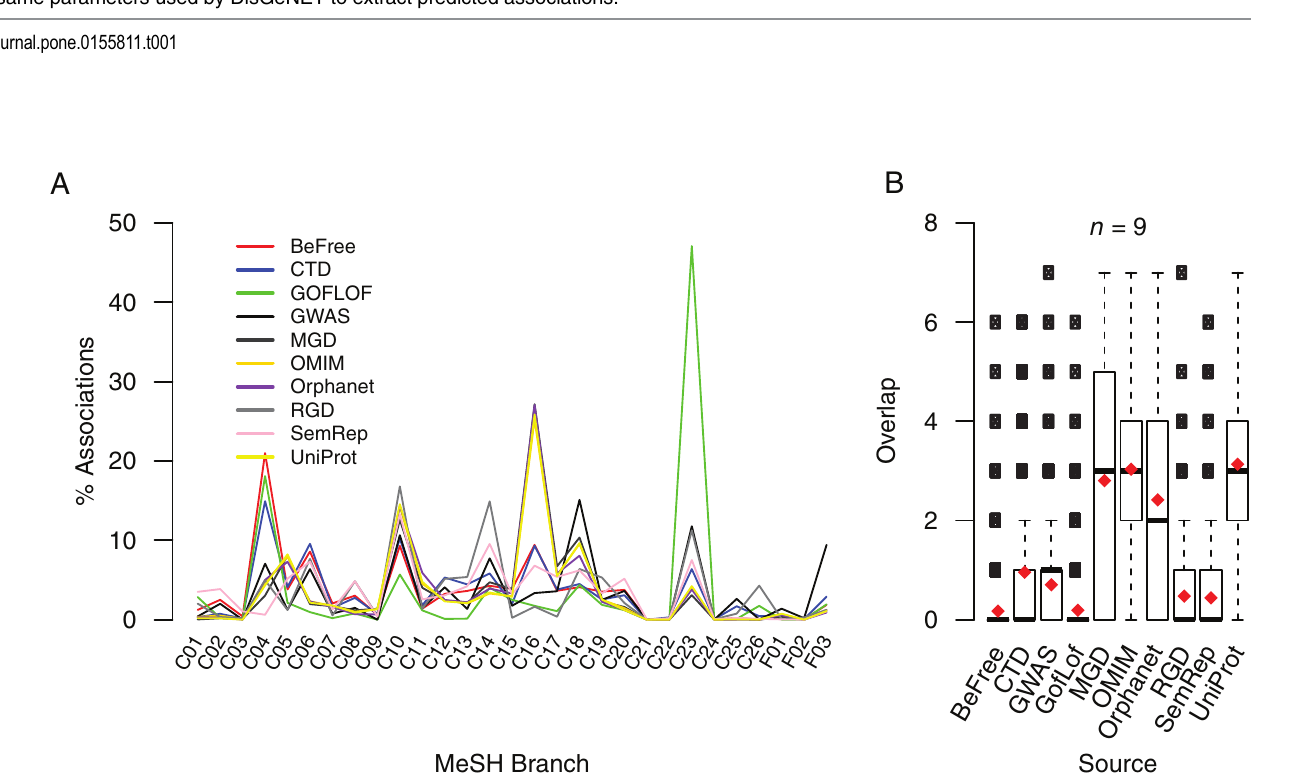
Fig 2. Comparison of gene-disease (G-D) sources. (A) shows the percentage spread of G-D associations from each integrated datasource across the 29 MeSH disease branches. (B) a boxplot showing the overlap of G-D associations between the ten datasources. x associations were picked at random and overlap between the other data sources identified ( x = 1000). Note : n = number of data sources checked, red diamonds show the mean, open circles are outliers and the median is represented by the thick horizontal black